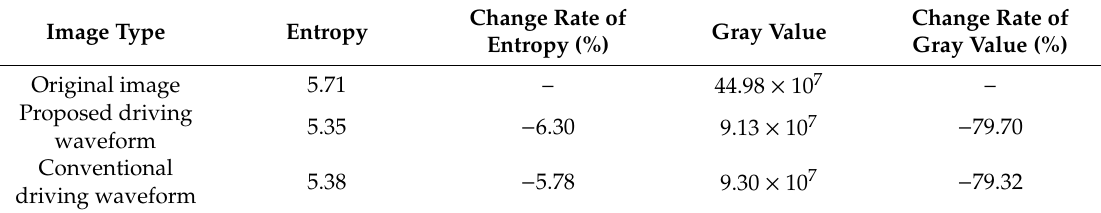
Table 2. The change of entropy and gray value.